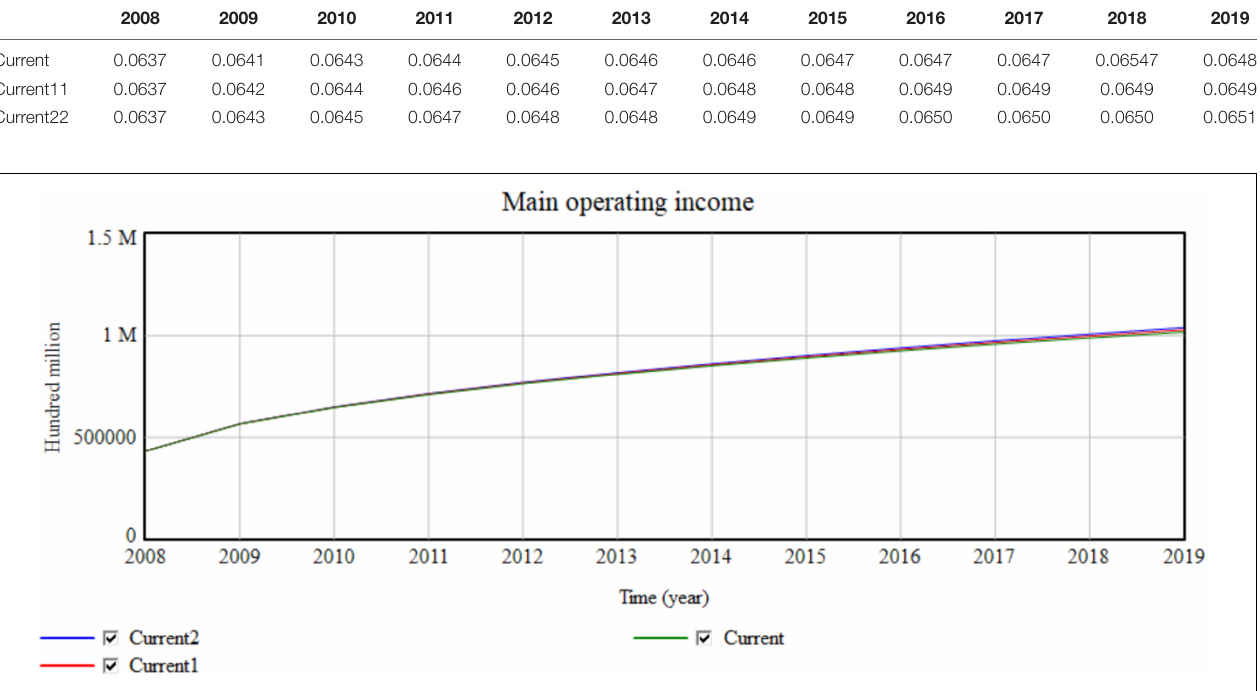
FIGURE 12 | Impact of investment in scientific and technological innovation on the operating income of the macro manufacturing industry.